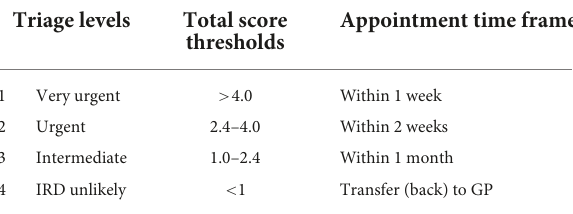
TABLE 2 Rheport’s triage levels, respective total score thresholds and appointment time